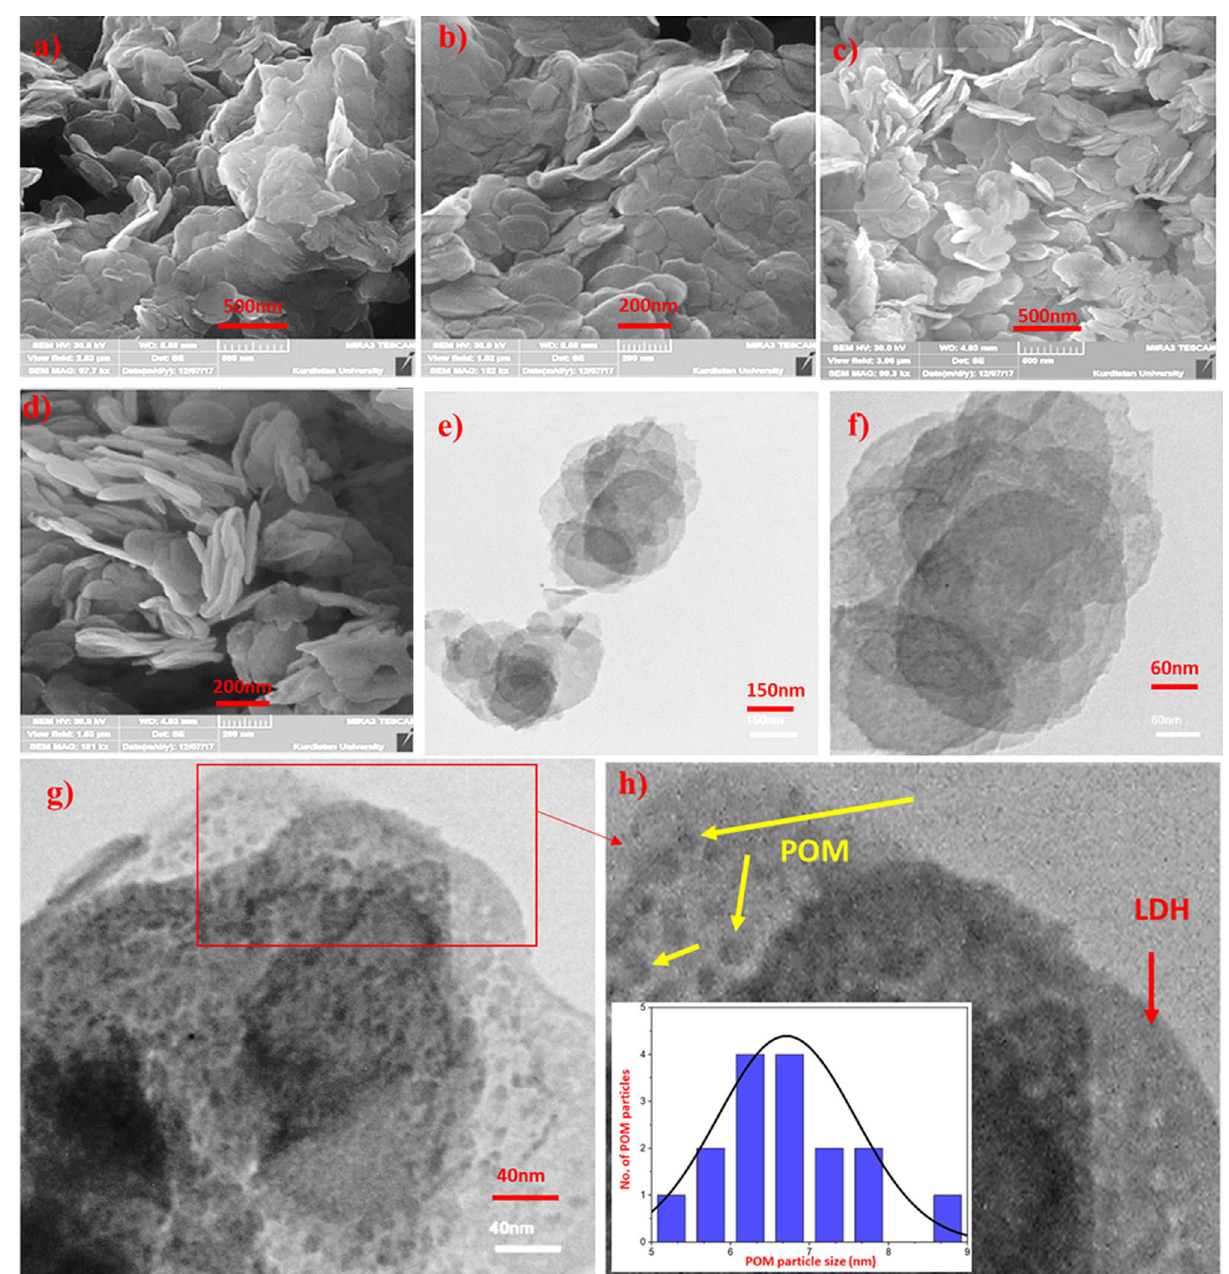
Figure 4. FE-SEM images of ( a , b ) Zn 3 Al–NO 3 ; ( c , d ) SiW 9 Ni 3 @Zn 3 Al; TEM images of ( e – h ) SiW 9 Ni 3 @Zn 3 Al. POM particle size histogram for